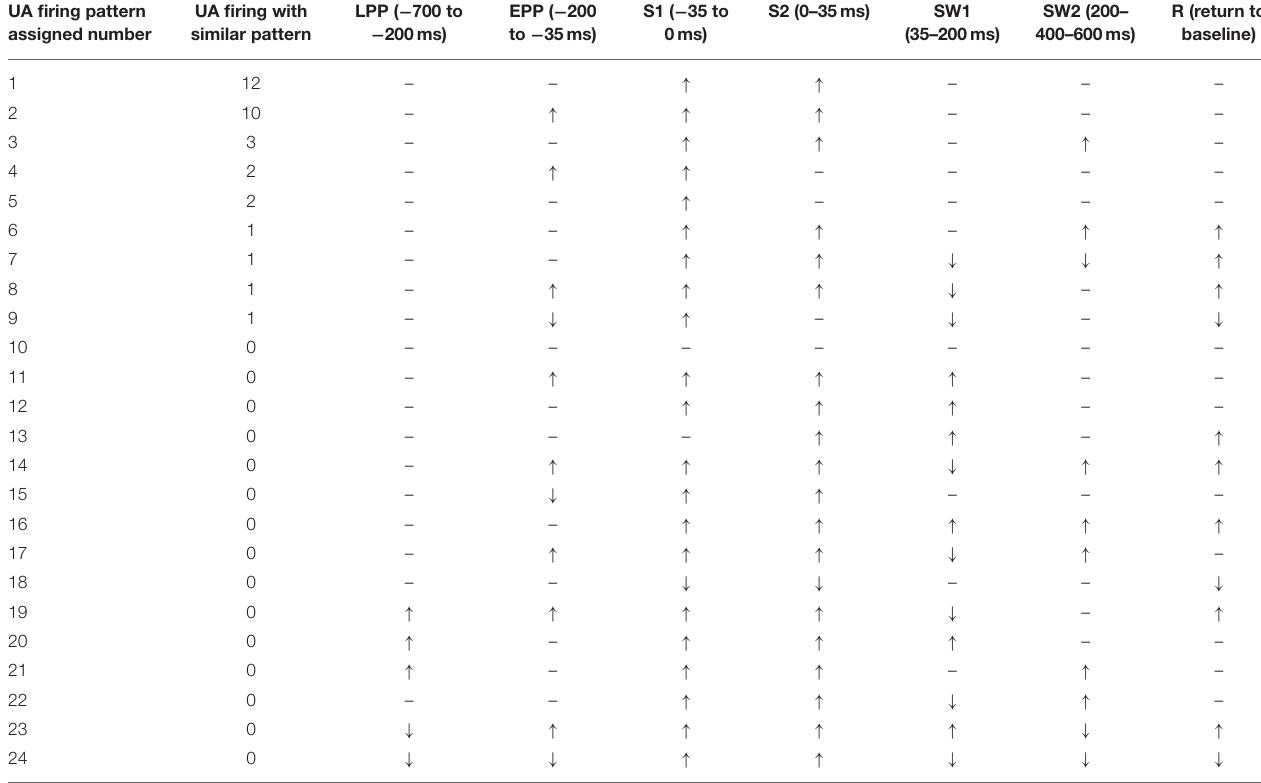
TABLE 2 | Classification of neuronal responses surrounding the interictal spikes. UA firing pattern assigned